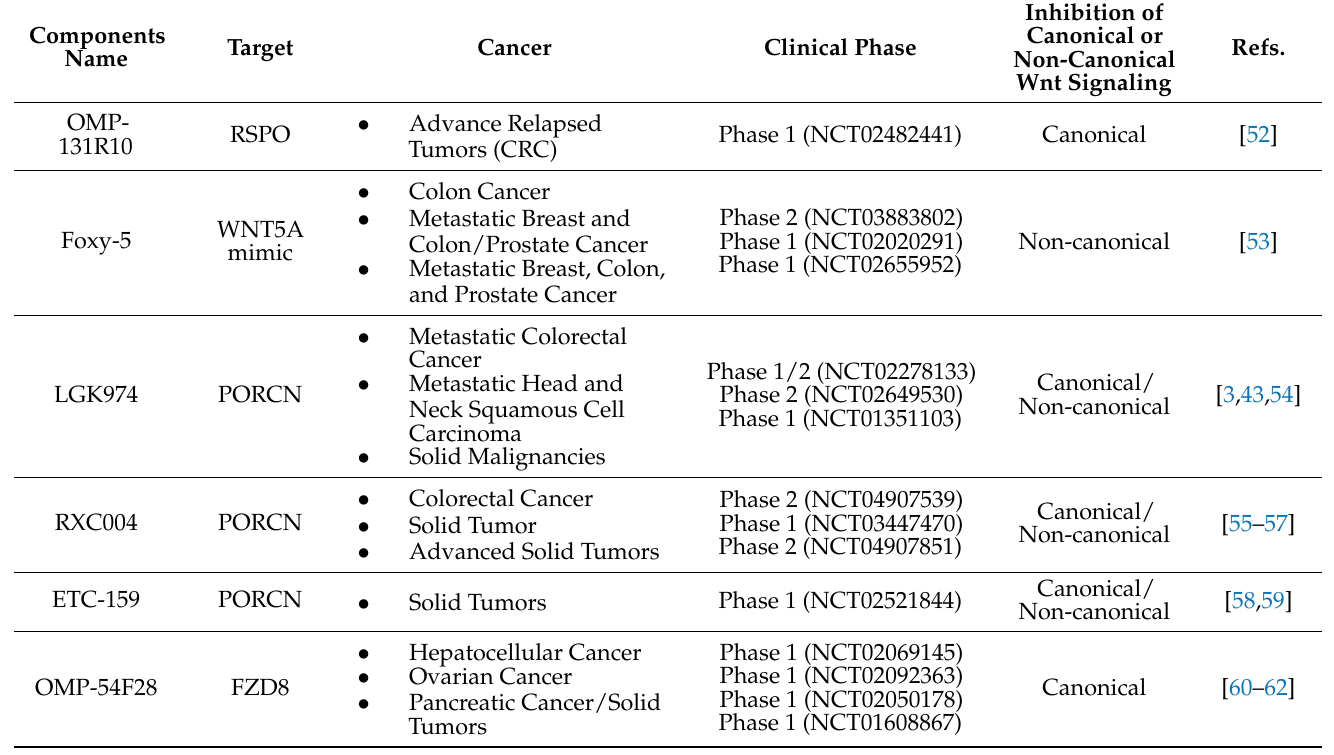
Table 1. Wnt signaling targeting agents in clinical trials for cancer